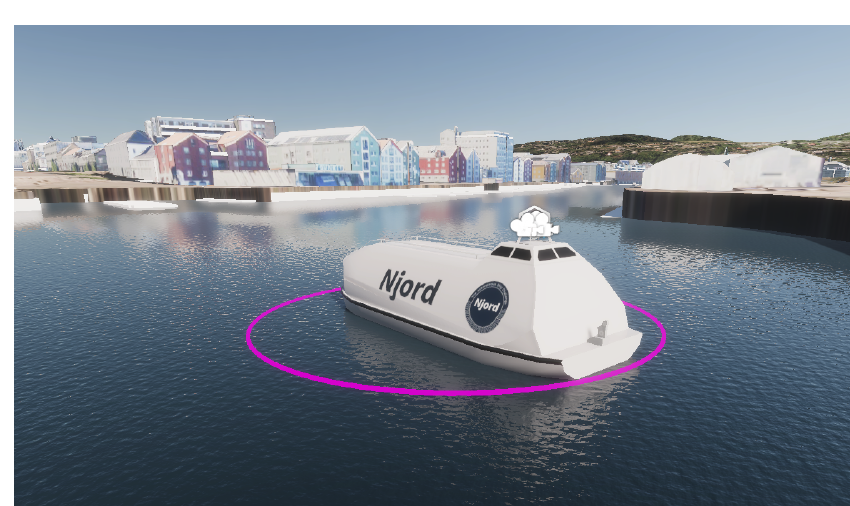
Figure 11. Njord vessel in the Autoferry Gemini simulator.